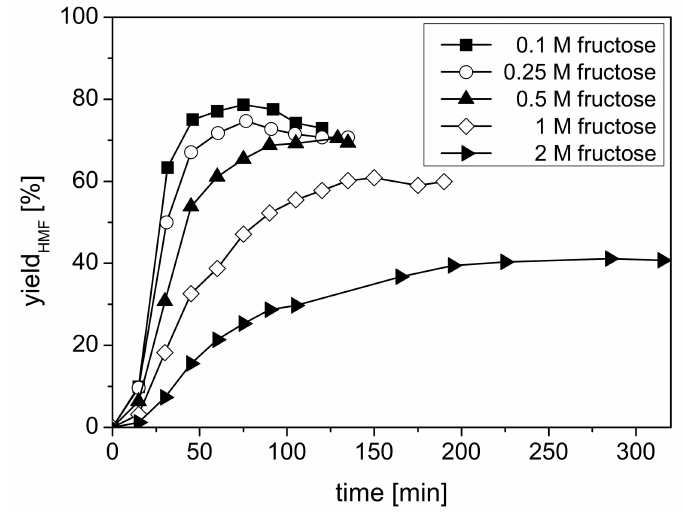
Figure 2. Effect of fructose concentration on the HMF yield. Reaction conditions: 0.1–2 M fructose, 15 vol % water in HFIP, 22 g/L (23.8 mol %) Lewatit K2420 and 110 ◦